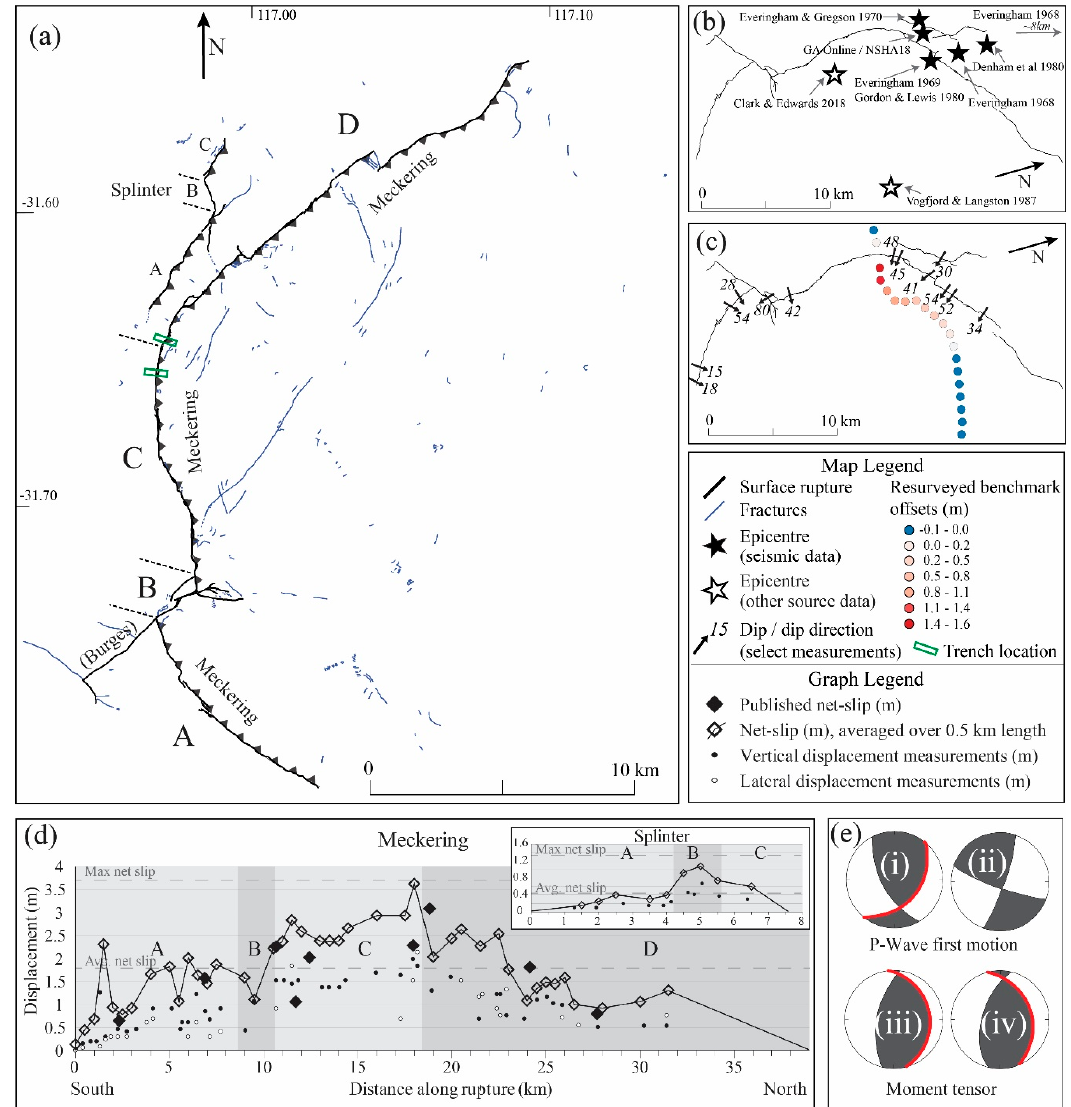
Figure 3. 1968 Mw 6.6 Meckering earthquake ( a ) rupture and fracture map of Meckering and Splinter scarps [25] with faults labelled as per displacement graphs, trench location from [37] ( b ) published epicenter locations, open stars show approximate locations of epicenters without published coordinates ( c ) selected dip measurements of scarp and displacement of resurveyed road bench marks [25] ( d ) graphs of along-rupture vertical and lateral displacement measurements and net slip calculations [25] and net slip calculated from available data averaged over 0.5 km increments (this study) ( e ) focal mechanisms (red line shows preferred plane from original publication) from (i) Fitch et al., 1973, (ii) Fitch et al., 1993 & Leonard et al., 2002, (iii) Fredrich et al., 1988, and (iv) Vogfjord and Langston 1987.